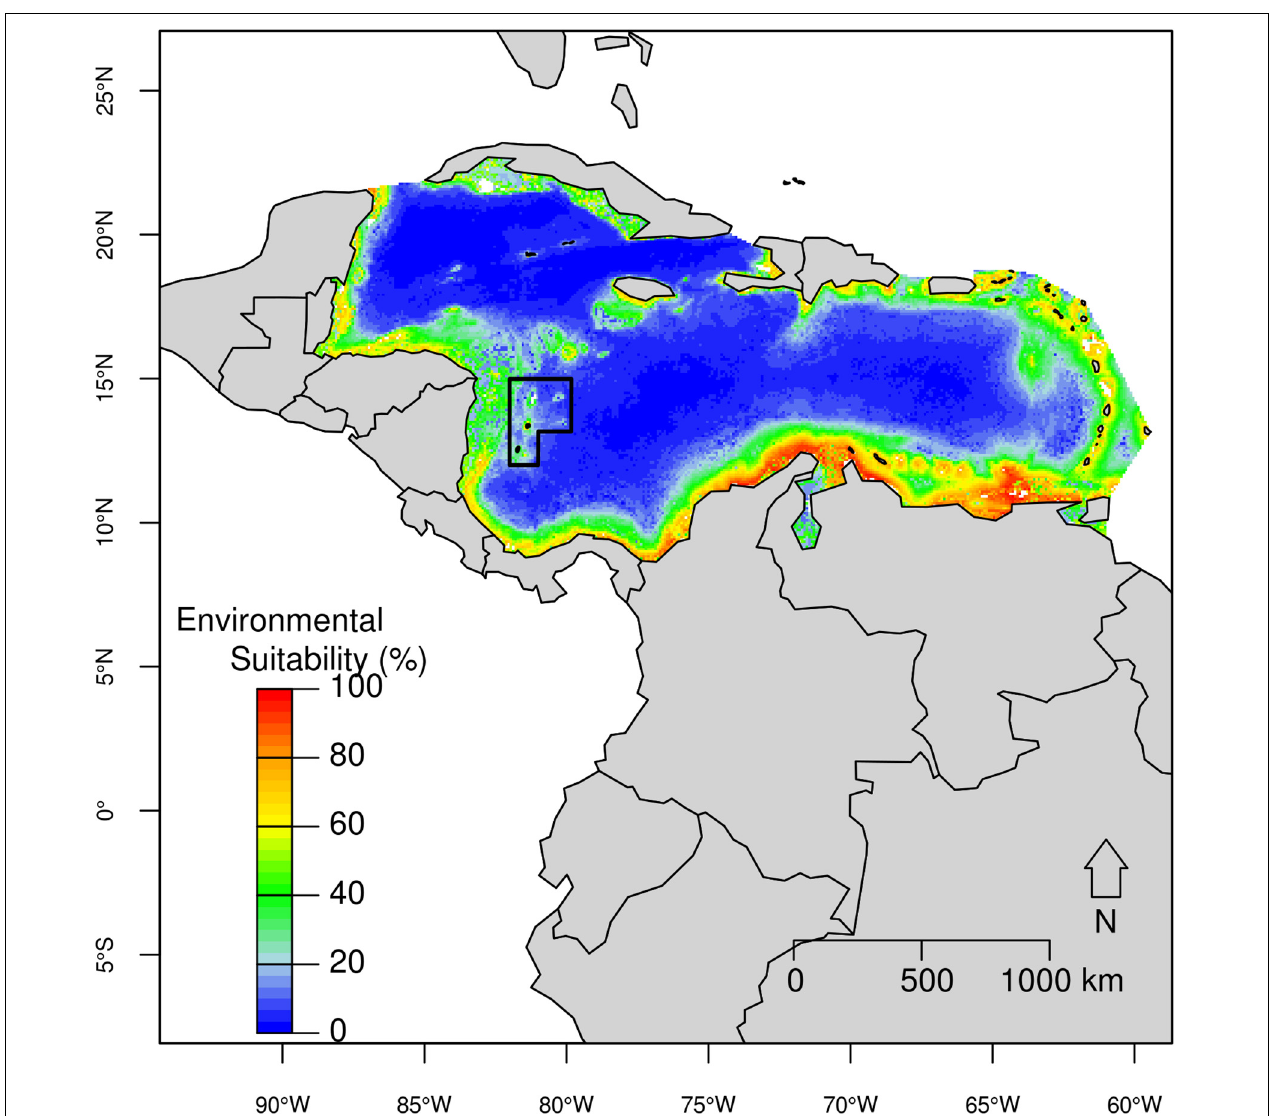
FIGURE 3 | Predicted potential distribution for the Atlantic spotted dolphin in the Caribbean Basin from the best ecological niche model. Red colors indicate highest habitat suitability and blue lowest